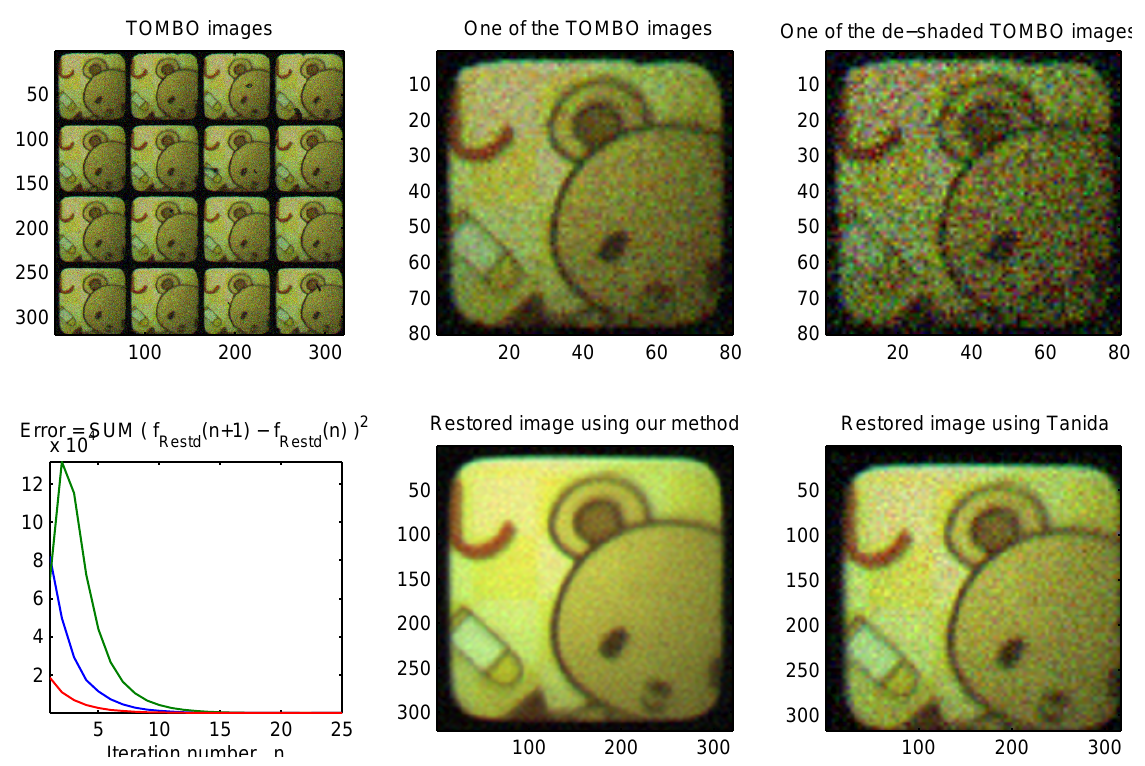
Figure 7. Experimental results, 4 × 4 unit images, D = 4 , L = 4 , ‘ = 5 , SNER = 15.774